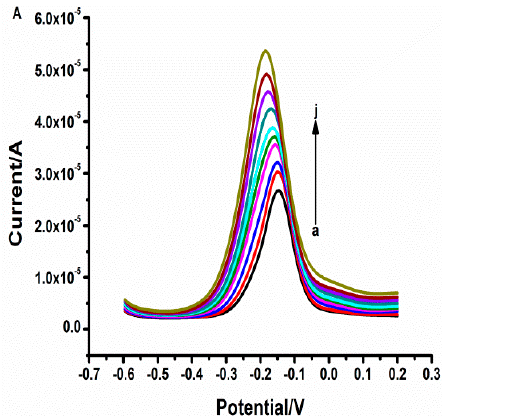
Figure 5. ( A ) differential pulse voltammetry curves of tau381 concentrations including 0, 1, 2, 5, 10, 20, 40, 60, 80, and 100 pM in 0.1 M PBS (pH 7.0); ( B ) Plot of Δ I vs Log of tau381 concentration (n > 3).